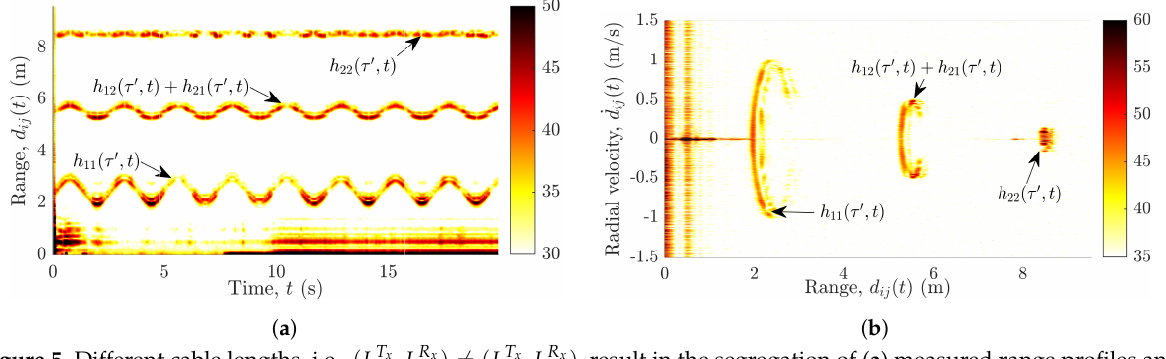
Figure 5. Different cable lengths, i.e., ( L T x ( b ) measured range–velocity